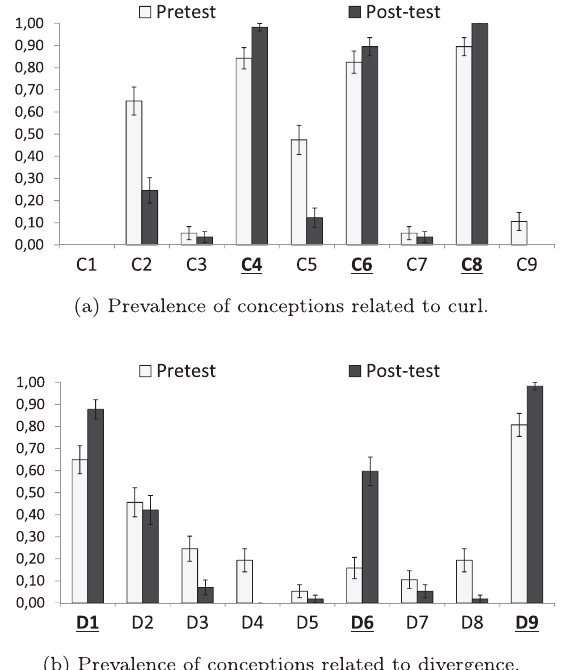
FIG. 6. The proportion of KU Leuven students ( N ¼ 57 ) who indicated that a statement presented in the questions in Fig. 5 is correct on the post-test, compared to the pretest. Only the students who took both the pre- and post-test were taken into account. Correct statements are in bold and underlined.